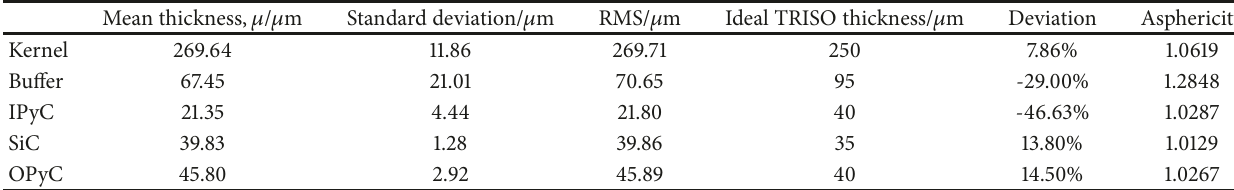
Table 1: 3D measurement for the TRISO particle.